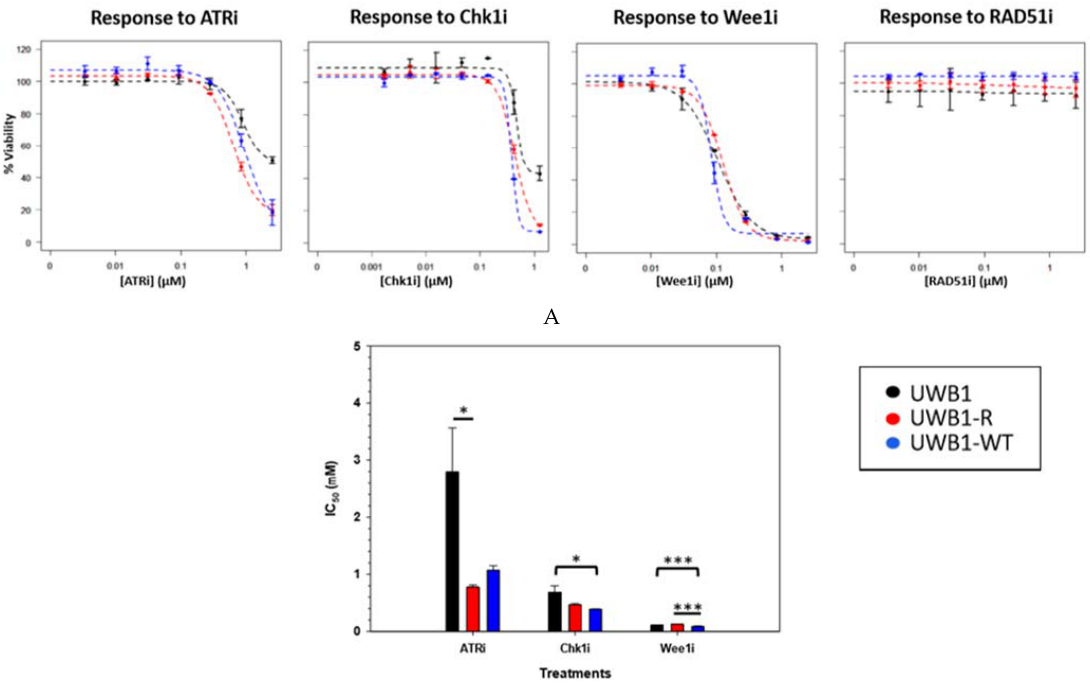
Figure 2. ( A ) Cell viability assay shown for cells versus screened inhibitors: ATRi, Chk1i, Wee1i and RAD51i. Cells were treated with media containing inhibitors for 144 h at increasing doses and the dose-response plotted for each cell line to estimate the IC 50 . Experiments were completed in duplicate with standard deviation error bars shown. ( B ) Estimated IC 50 for each cell line. IC 50 of ATRi was estimated to be 2.8 ± 0.77 µ M, 0.78 ± 0.04 µ M and 1.1 ± 0.08 µ M for the UWB1, UWB1-R and UWB1-WT cells, respectively. IC 50 of UWB1-R cells was significantly lower compared to UWB1 cells ( α < 0.05). IC 50 for the Chk1i was: 0.69 ± 0.11 µ M, 0.47 ± 0.02 µ M and 0.39 ± 0.004 µ M respectively. UWB1-WT was significantly lower than UWB1 ( α < 0.05). IC 50 for the Wee1i: 0.11 ± 0.005 µ M, 0.13 ± 0.05 µ M, and 0.09 ± 0.005 µ M for UWB1, UWB1-R and UWB1-WT respectively. UWB1-WT was significantly lower than UWB1 and UWB1-R cells ( α <